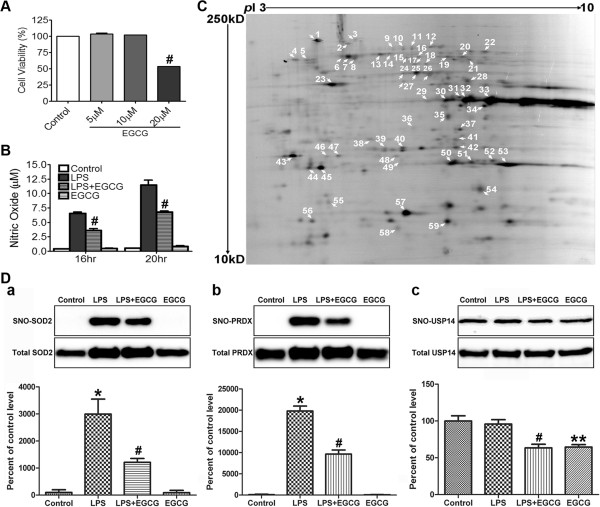
Effect of EGCG on LPS-induced protein S-nitrosylation in BV-2 cells. (A) Dose titration for EGCG. BV-2 cells were treated with 0, 5, 10, and 20 μM EGCG for 20 hours and cell viability was assessed by a MTT assay (# P <0.01, control vs. 20 μM EGCG, n = 3). (B) Administration of EGCG (10 μM) 1 hour prior to LPS (100 ng/mL) exposure inhibited NO production in BV-2 cells (# P <0.01, LPS vs. LPS + EGCG, n = 3). (C) A total of 59 differentially S-nitrosylated protein spots were detected by NitroDIGE analysis (fold change > 1.3, P <0.05, LPS vs. LPS + EGCG, n = 3). (D) Seventy-eight proteins were identified from the above spots by LC-MS/MS, and SOD2 (a), PRDX (b), and USP14(c) were selected for validation by the BST method. After Biotin-HPDP labeling and biotin affinity pull-down, individual protein Western blotting was performed. The amount of SNO-proteins was quantified by a densitometer, normalized to total proteins, and expressed as percentage of untreated controls. Data are means ± SEM (n = 3); * P <0.05, untreated vs. LPS; # P <0.05, LPS vs. LPS + EGCG; ** P <0.05, untreated vs. EGCG. The results showed the down-regulation of S-nitrosylation levels of these proteins in “LPS + EGCG” compared to LPS-treated samples.